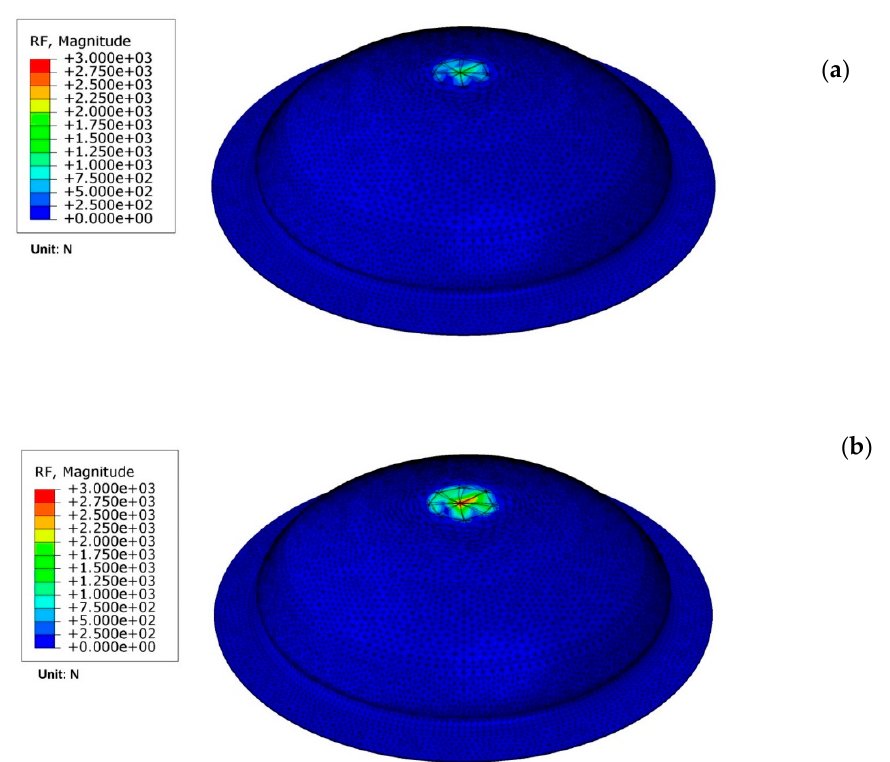
Figure 7. Two representative cloud maps of the reaction force taken from successive loading at 300 K.